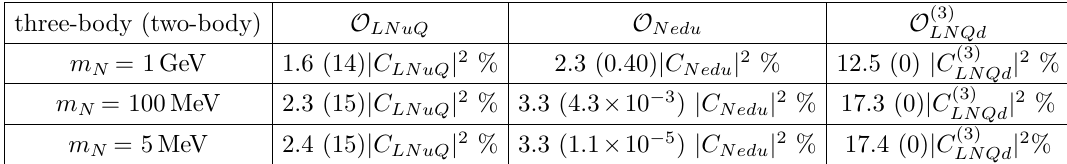
Table 2 . Branching fractions for ¯ B 0 → D + ‘ − ¯ N, D ∗ + ‘ − ¯ N and B − → ‘ − ¯ N (in